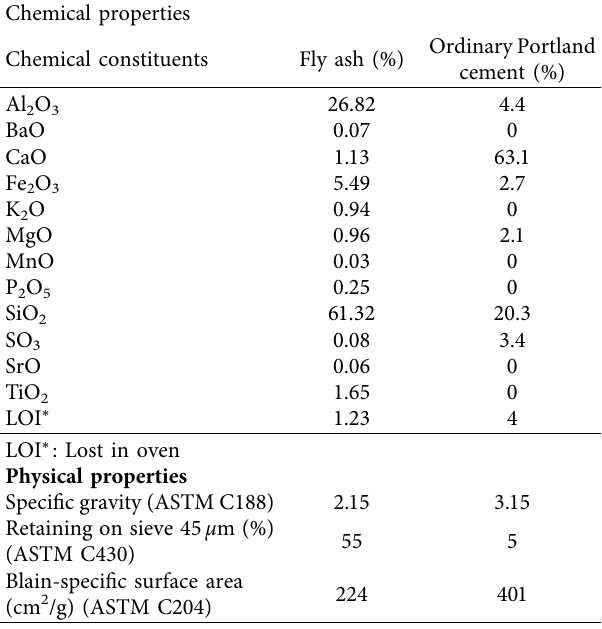
Table 1: Properties of the active filers [23]. Chemical properties Chemical constituents